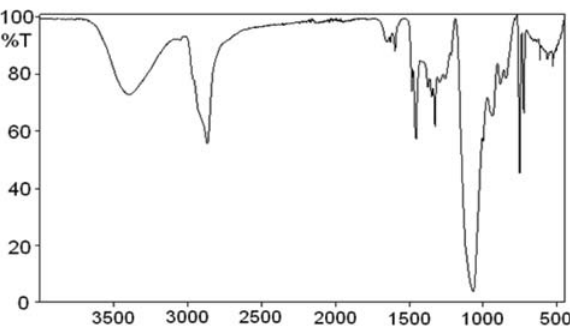
Fig. 3. IR spectrum of oligoetherol obtained from C : GL :EO:PO = 1 : 7 : 4 : 6 molar ratio system